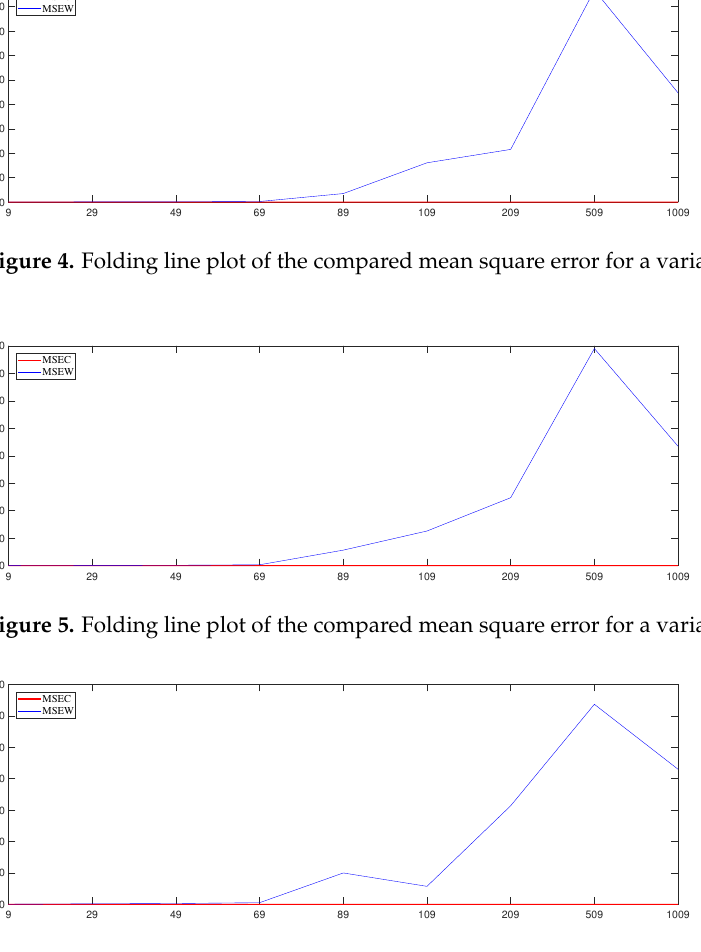
Figure 6. Folding line plot of the compared mean square error for a variance of 2. Line plots of the mean square errors for different variances were constructed with a sample size of 200 to specifically express the effects of this study (Figures 7–9) and for a comparison with Wang’s results (Figures 10–12).